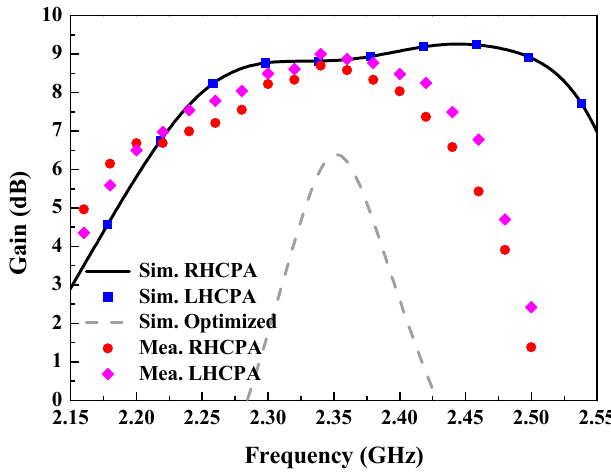
Figure 10. Simulated and measured gain of the RHCPA and the LHCPA and simulated gain of the optimized EPA as a function of frequency.